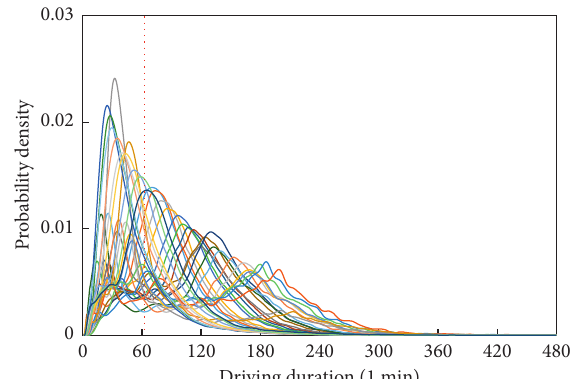
Figure 4: Variety of distributions of driving durations.